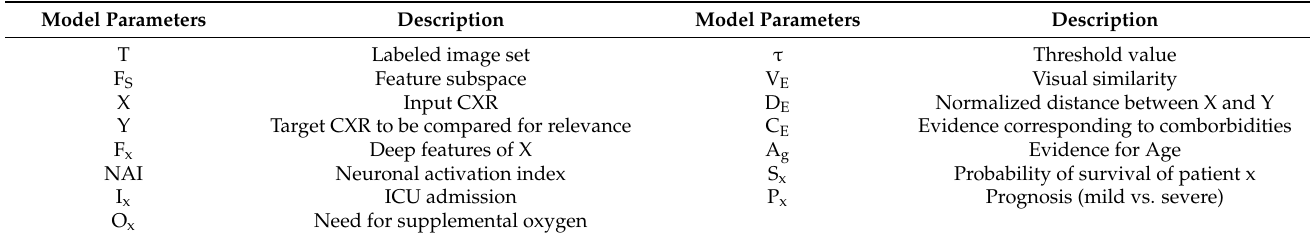
Table 2. Description of nomenclature